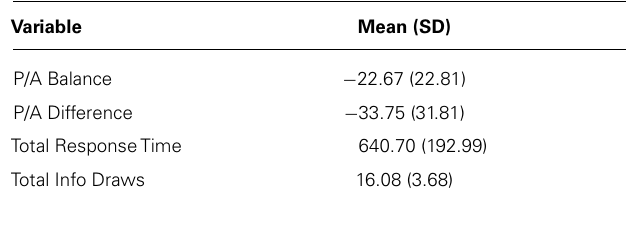
Table 1 | Descriptive statistics for predictor and outcome variables.